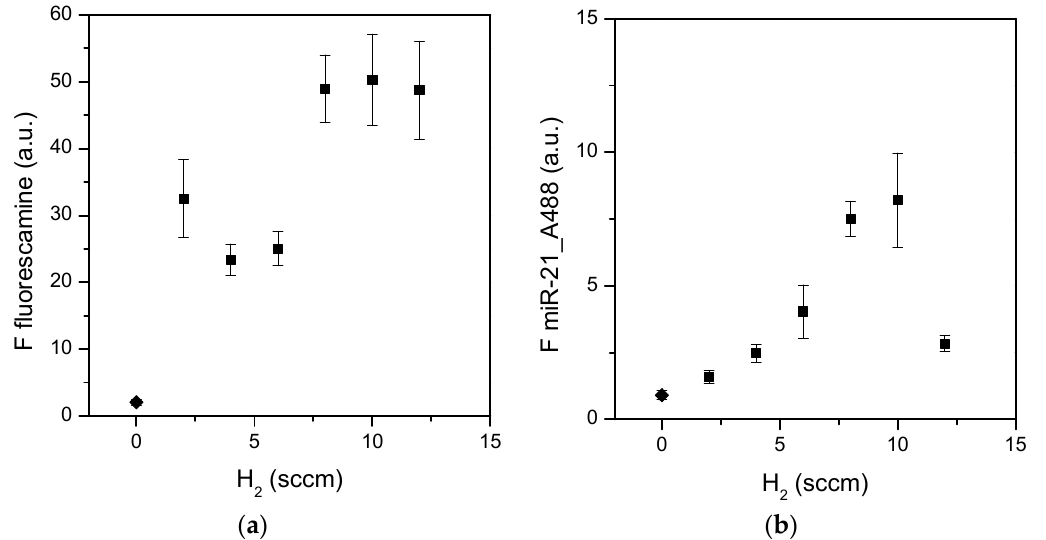
Figure 3. Fluorescamine assay ( a ) and miR-21 adsorption ( b ) on plasma-coated surfaces in the ternary CH 4 /NH 3 /H 2 gas feed. Fluorescence data (squares) are reported as a function of the H 2 concentration. Diamonds near zero represent control fluorescence measured on pure silicon surfaces. Data are means of at least three surfaces; standard errors are reported ( n ≥ 3).